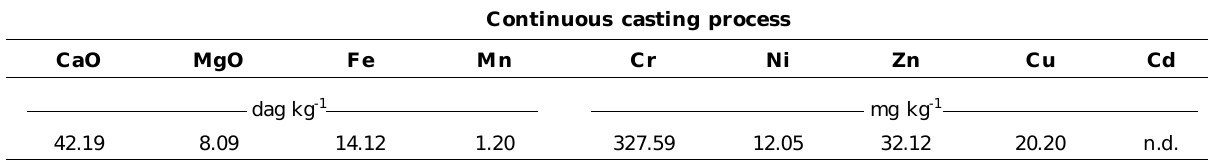
Table 2. Chemical analyses of steel slag sample from the company ArcelorMittal